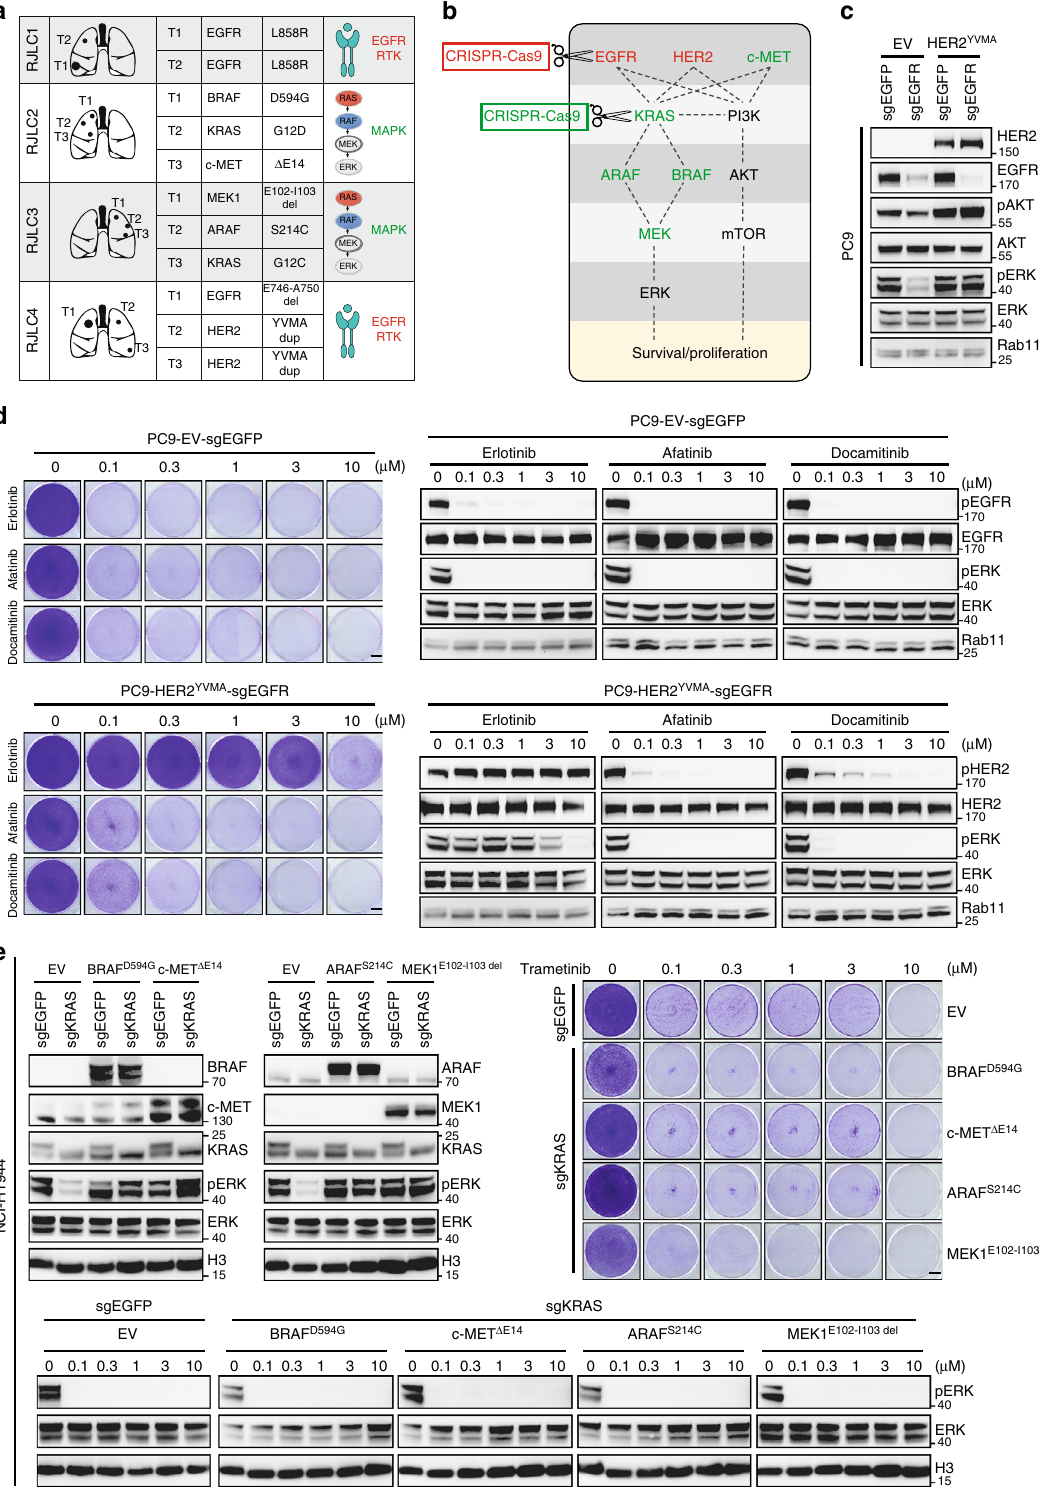
Fig. 3 Constrained tumorigenic pathways among multicentric lesions. a A summary of the most prominent driver mutation identi fi ed in each primary tumor of MSLC. b EGFR or KRAS was knocked out using CRISPR-Cas9 system in lung cancer cell lines and replaced with HER2, c-MET, ARAF, BRAF, or MEK mutants. c EGFR was knocked out using CRISPR-Cas9 system in PC9 cells and replaced with HER2 YMVA . AKT and ERK phosphorylation were measured by western blot analysis. d Cells were treated with a serial dilution of indicated inhibitors for a week and stained with crystal violet. Scale bar, 5 mm. The corresponding cell lysates were analyzed by immunoblotting. e KRAS was knocked out using CRISPR-Cas9 system in NCI-H1944 cells and replaced with BRAF D594G , c-MET Δ E14 , ARAF S214C , or MEK1 E102-I103 del . ERK phosphorylation was measured by western blot analysis. Indicated cells were treated with a serial dilution of trametinib for a week and stained with crystal violet. Scale bar, 5 mm. The corresponding cell lysates were analyzed by